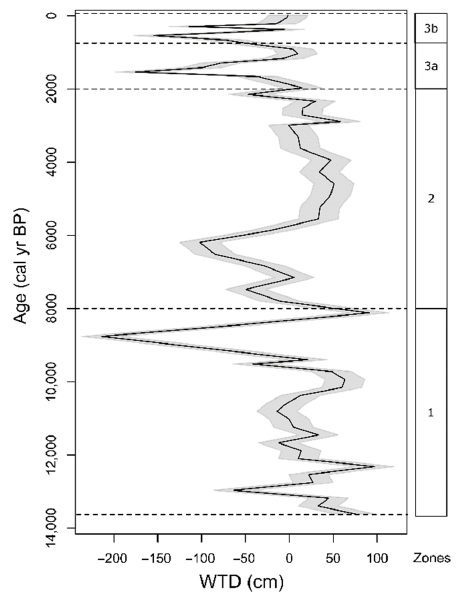
Figure 5. Reconstruction of water table depths (WTD, cm) based on the functional trait composition of testate amoeba communities using the multiple regression transfer function. The zonation is based on the constrained cluster analysis of the morphospecies composition of testate amoeba communities (see Figure 2).